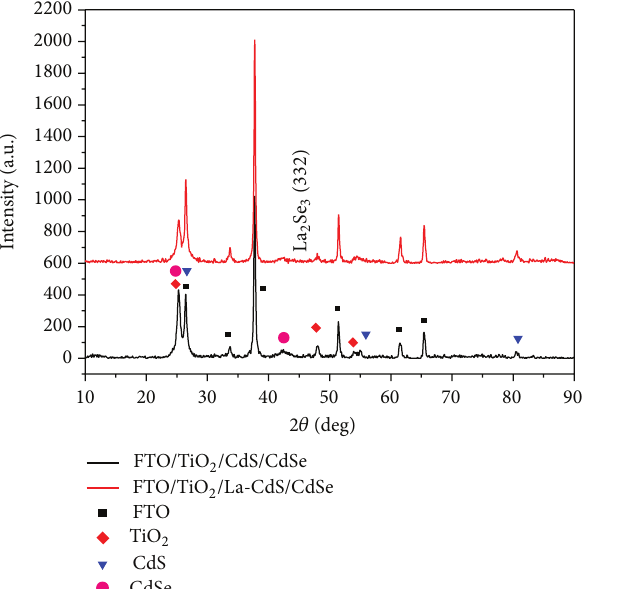
Figure 7: UV-Vis absorption spectroscopy of La-CdS/CdSe pho- toanode of different SILAR cycles.